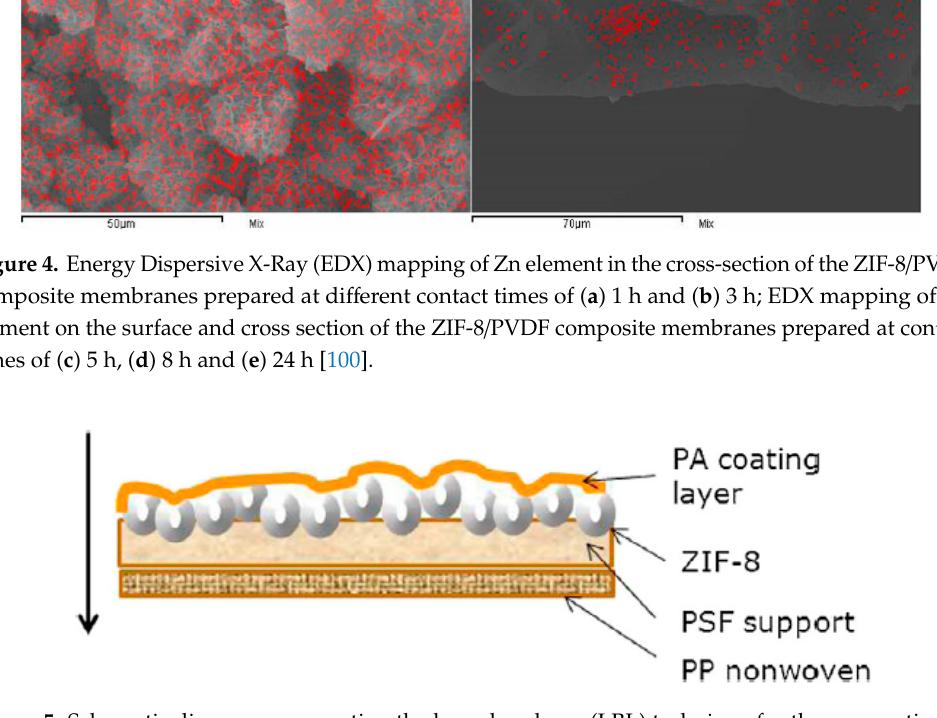
Figure 6. Schematic diagram of gelatin-assisted growth of ZIF-8 on the ( a ) outer and ( b ) inner surface of a PVDF hollow fiber with their corresponding SEM images [30].